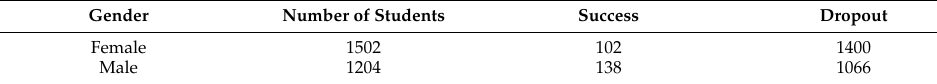
Table A2. Distribution of Students Across Different Gender Groups.